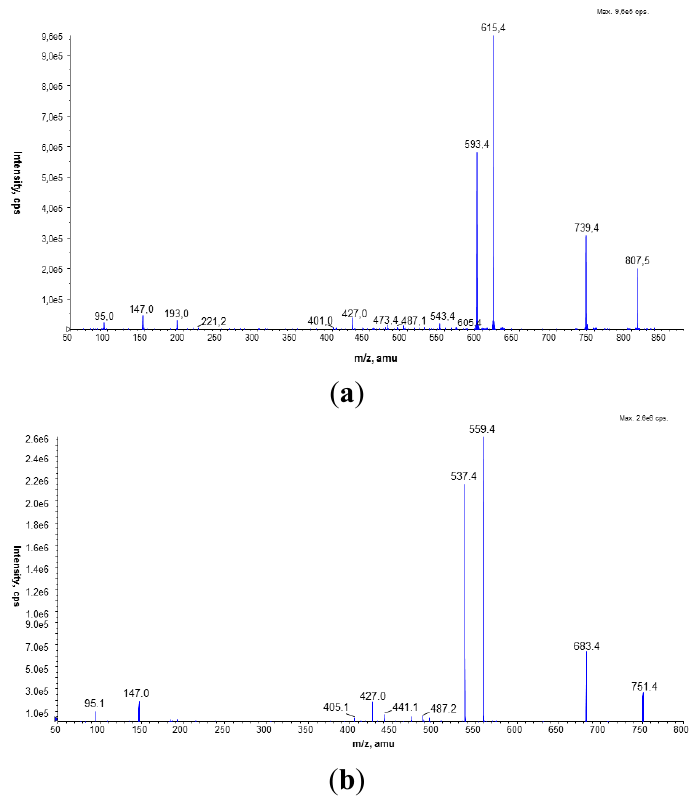
Figure 6. ( a ) CID spectrum of labeled 20:0/15:0 PC molecular species identified in the lipid mixture isolated from the inner membrane ( L. dumoffii cultivated on the medium with labeled choline), recorded under NP LC/MS conditions (phase A—hexane/isopropanol (3:2, v / v ) and phase B—an isopropanol/hexane/5 mM aqua solution of ammonium acetate (38:56:5, v / v / v ). The following elution program was employed: from 53% B to 80% B